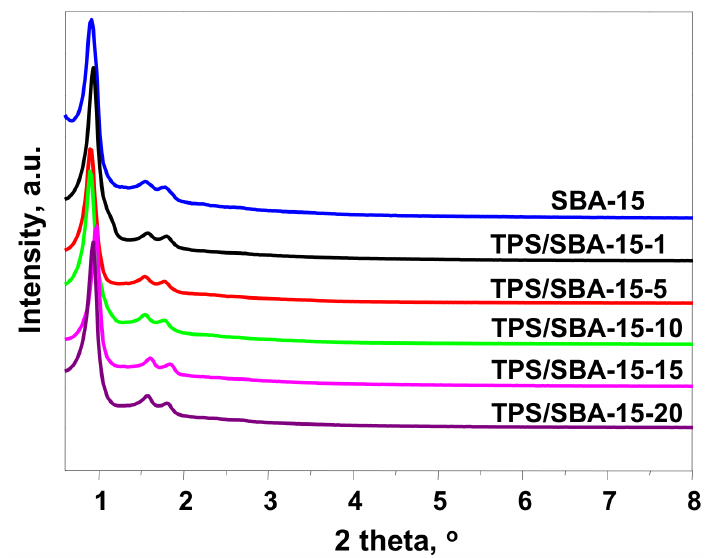
Figure 1. XRD patterns of materials obtained.